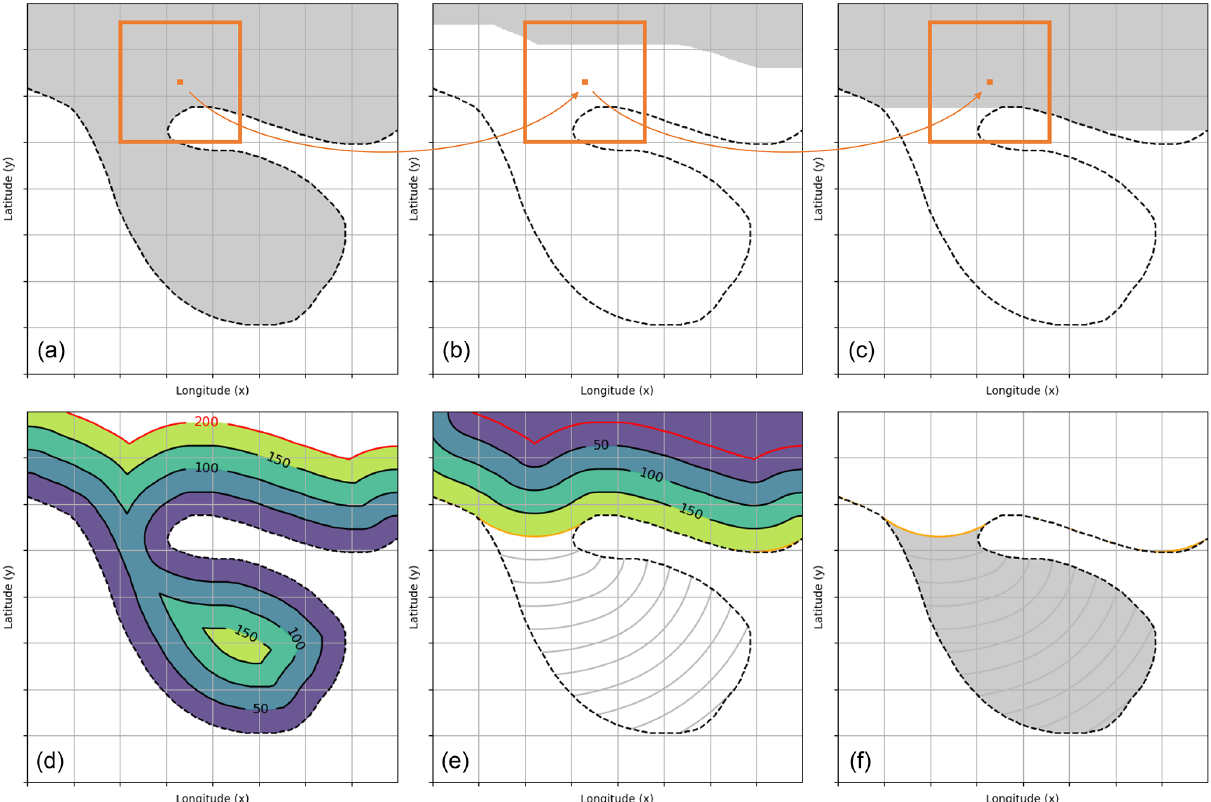
Figure 1. A sketch of our identification strategy applied to a PVS-like structure. (a–c) The process of a morphological opening (erosion followed by dilation) is applied to the gray structure using a square mask (orange). This removes thin structures depending on the mask’s size. (d–f) Our adapted strategy, which uses distances instead of a binary mask. First, the distance emerging from the outer boundary is computed. Then, starting at a set distance (red line), the same distance is added back, respecting the boundaries of the domain. Areas not reconstructed are identified as